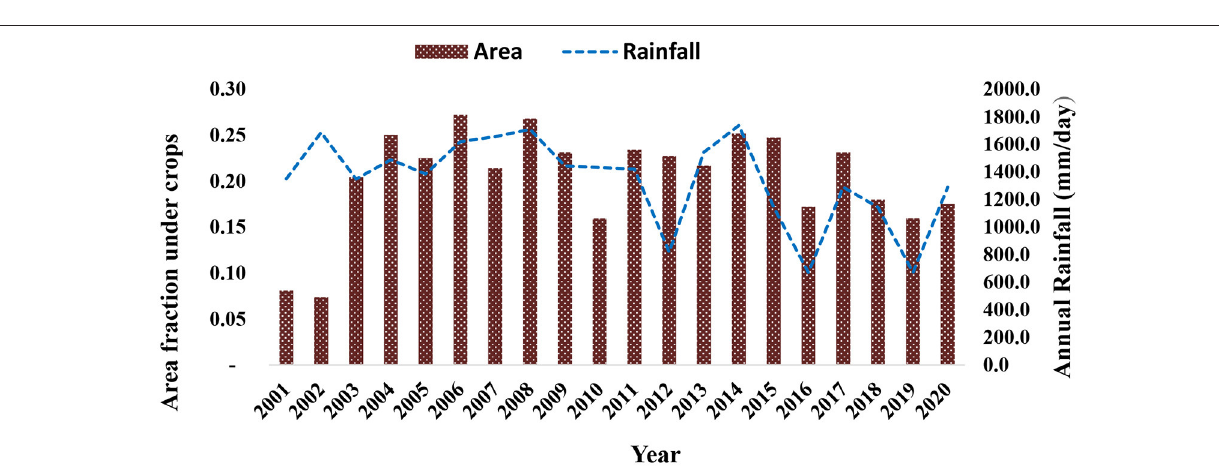
FIGURE 6 | Area fraction of crops grown, as a fraction of total agricultural land in the basin. Also shown annual rainfall over the